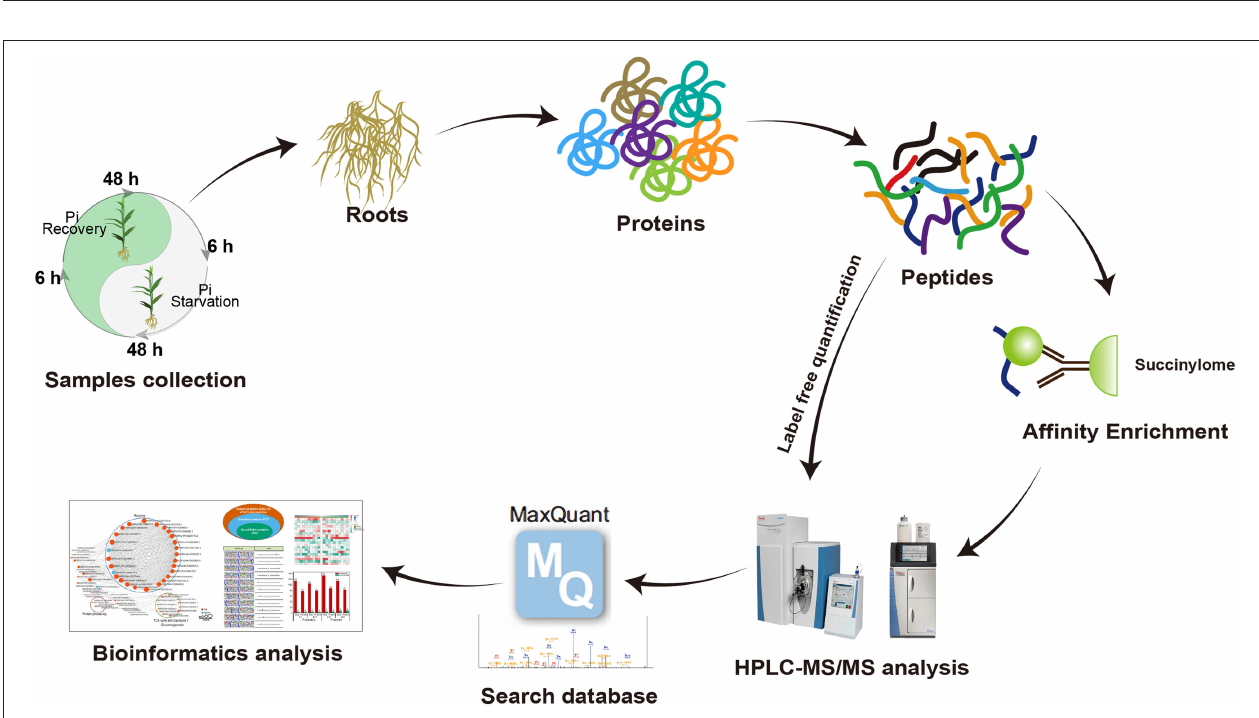
FIGURE 3 | Workflow used to analyze lysine succinylation in seedling roots in response to Pi starvation and recovery.